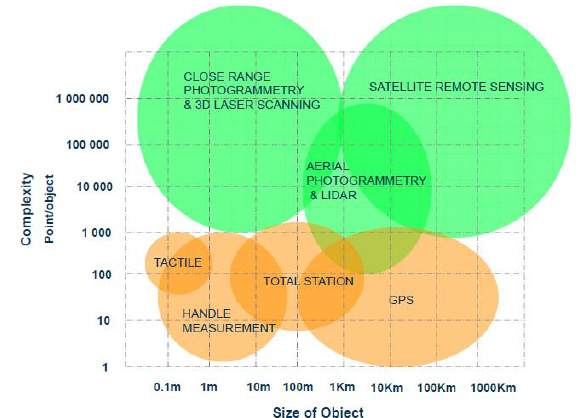
Fig. 1. Comparison of Survey Techniques of Heritage recording (From: Metric Survey for Heritage Documentation )